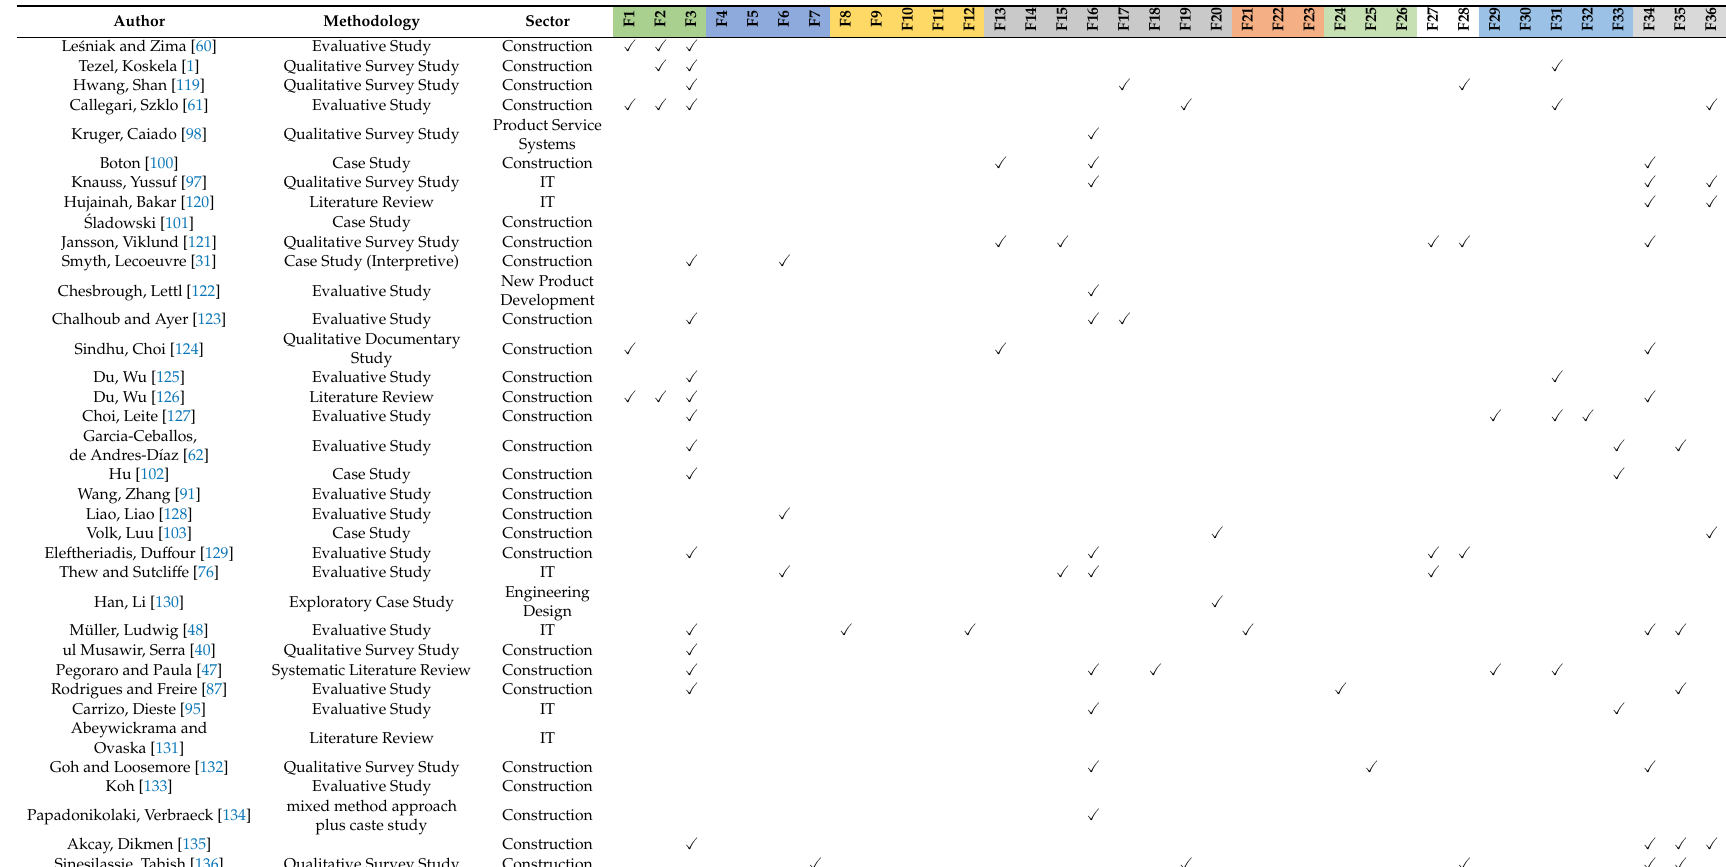
Table A2. Reviewed Studies by year, methodology, sector and requirements factors